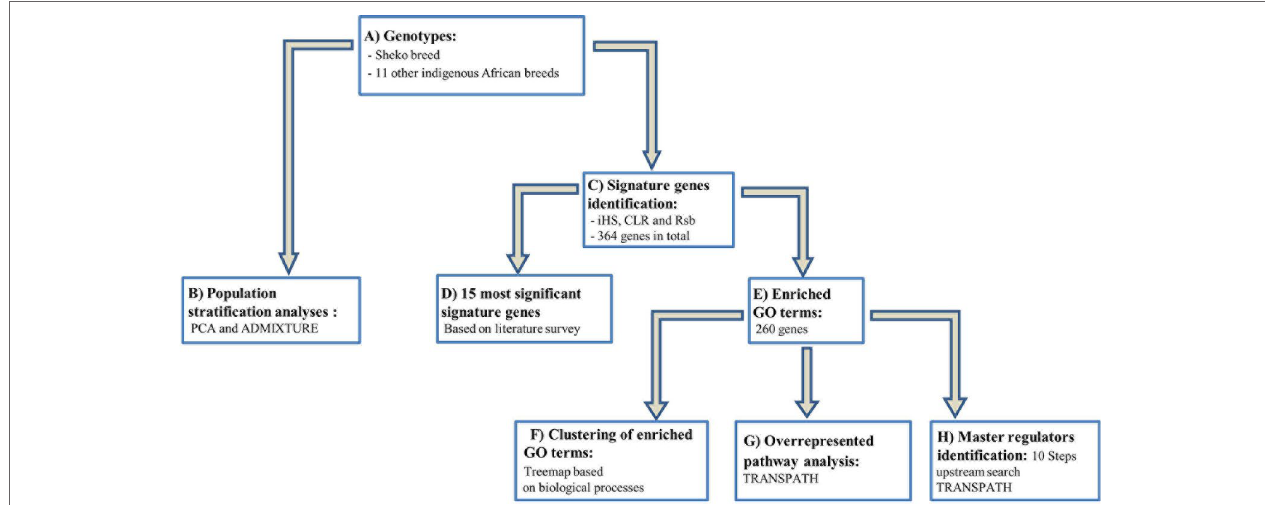
FIGURe 1 | Workflow for the study to identify candidate genes and key regulators that are associated with trypanotolerance in Sheko breed. (A) The genotypes of the Sheko and 11 other indigenous African breeds are obtained and quality control filtering is performed. (B) The genomic structure of Sheko in comparison to 11 other indigenous African breeds is analyzed using principal component analysis (PCA) and ADMIXTURE. (C) The identification of 364 signature genes is performed by iHS , CLR, and Rsb analyses. (D) Among 364 genes, the 15 most significant genes that are associated with trypanotolernace attributes are identified and disclosed. (e) Significantly functionally enriched terms [gene ontology (GO) terms] are identified for the 364 signature genes. 260 genes are identified as significantly enriched. (F) Using the functionally enriched 260 genes, a treemap is produced based on the biological processes. (G) Functionally enriched signature genes (260 genes) are analyzed to identify overrepresented pathways. (h) A master regulator network is generated up to 10 steps upstream using functionally enriched signature genes. The treemap, overrepresented pathway, and master regulator analyses were performed in the geneXplain platform.